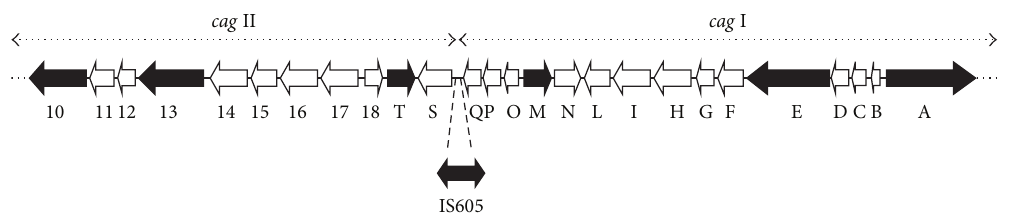
Figure 1: Structure of H. pylori cag pathogenicity island. The localizations of cag I, cag II, and IS605 are shown. The genes assessed in this study including cagA , cagE , cagM , cagT , orf 10, and orf 13 are indicated as close black.